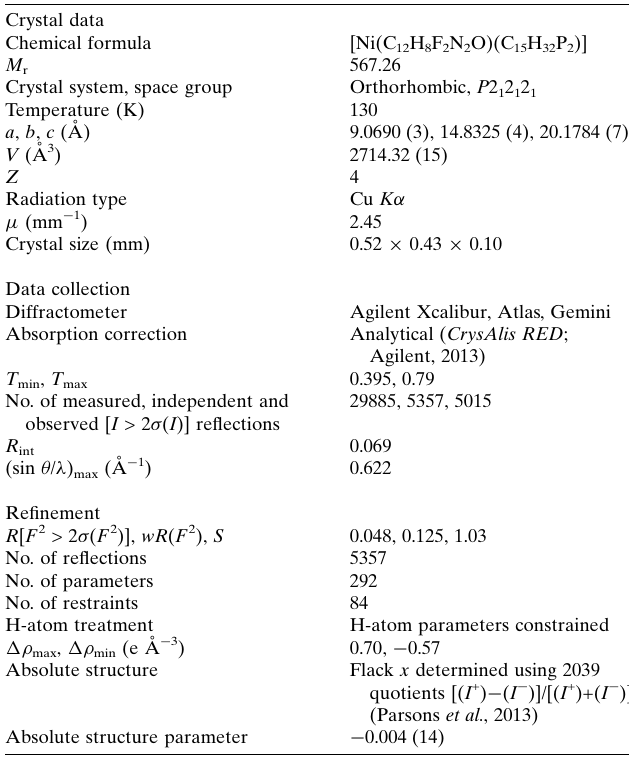
Table 1 Selected geometric parameters (A˚ , (cid:4) ). Ni1—N1